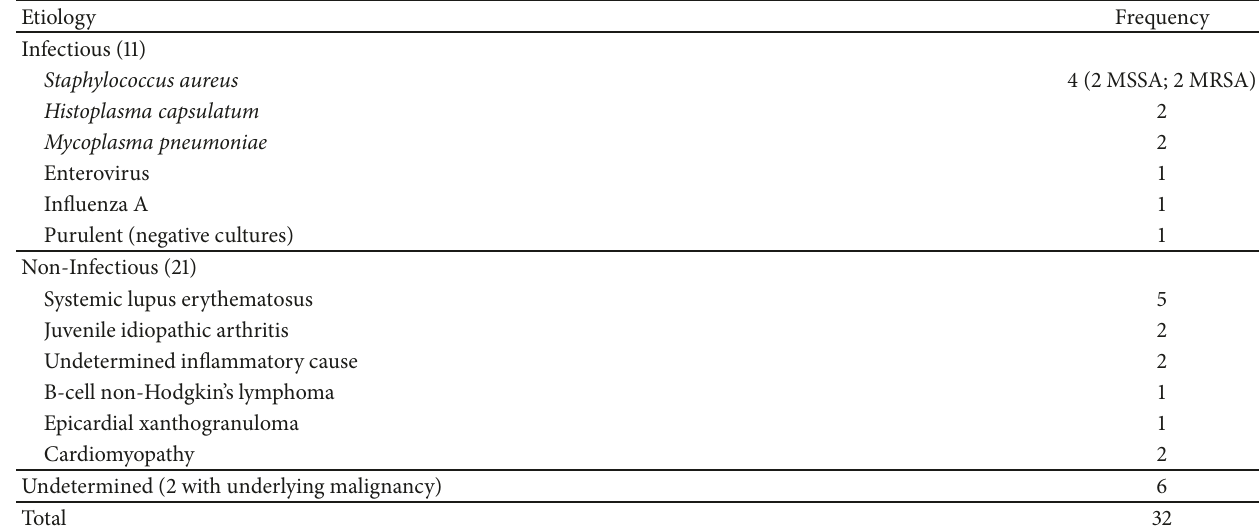
Table 1: Causes of acute pericarditis in 32 children